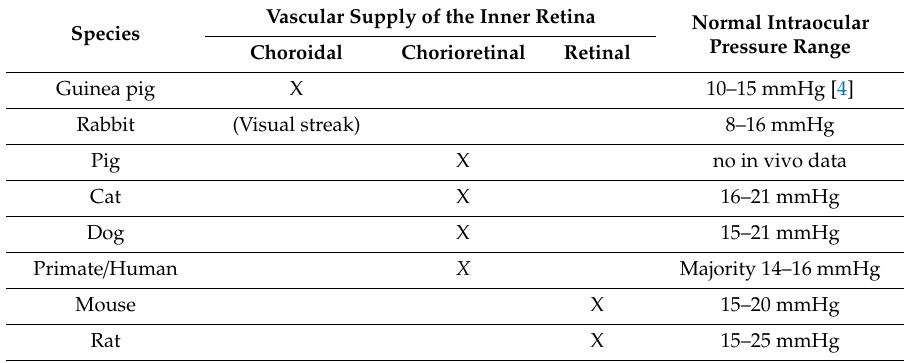
Table 1. Classification of various laboratory mammals due to their vascular supply of the inner retina and their normal range of intraocular